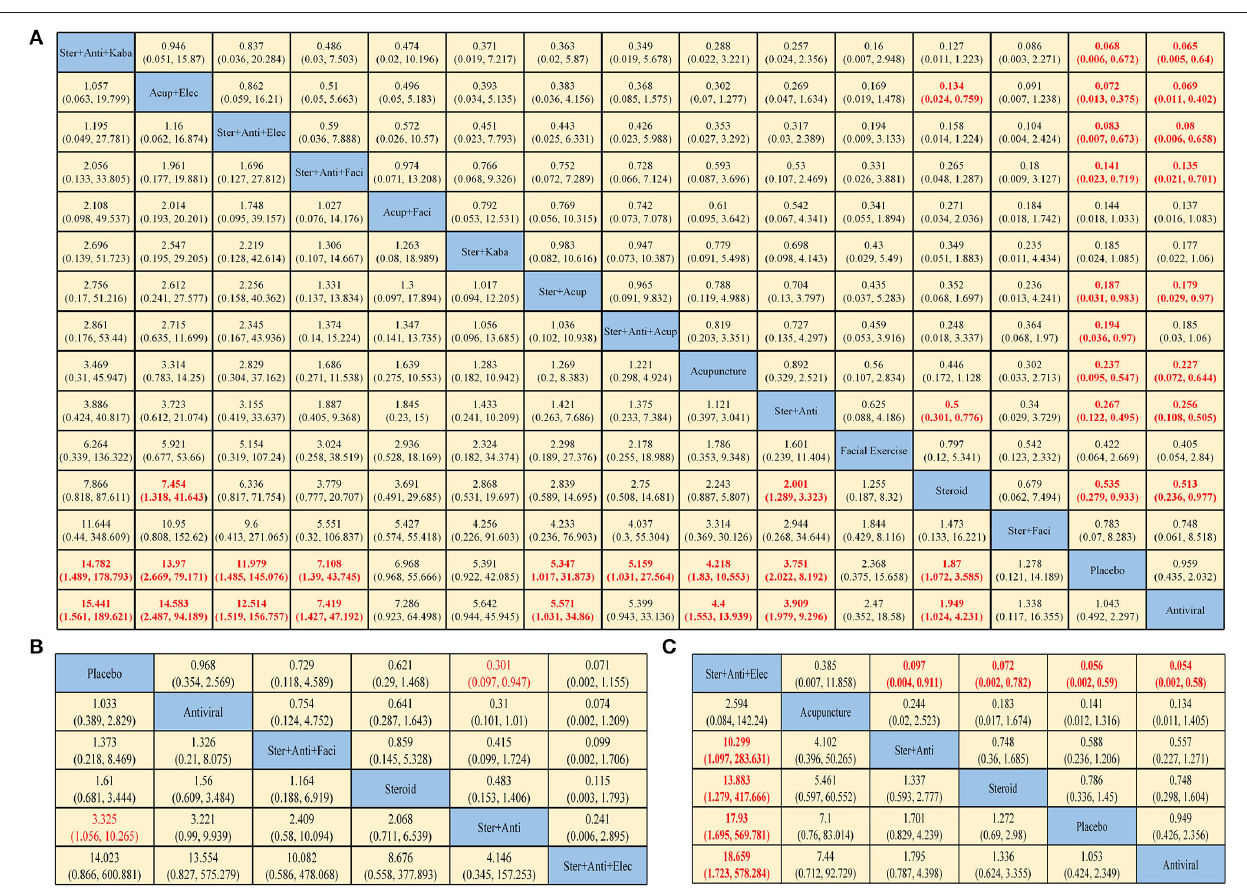
FIGURE 2 | Pooled estimates of the network meta-analysis. Pooled hazard ratios (95% credible intervals) for facial recovery (A) , sequelae (B) , and adverse events (C) . Data in each cell are odds ratios (95% credible intervals) for the comparison of row-defining treatment vs. column-defining treatment. Odds ratios more than 1 favor row-defining treatment. Significant results are in red (Ster, Steroid; Anti, antiviral; Kaba, Kabat treatment; Elec, Electrical stimulation; Acup, Acupuncture; Faci, Facial exercise).